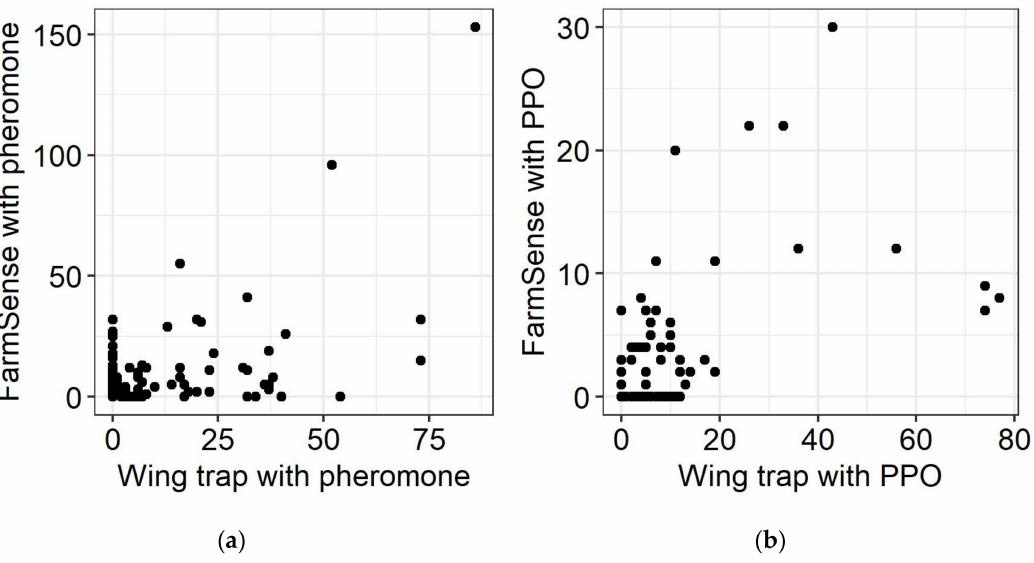
Figure 4. Association of counts from pseudoacoustic sensors and navel orangeworm captured in wing traps when both were baited with: ( a ) A pheromone monitoring lure ( ρ = 0.24, p = 0.02)); or ( b ) a phenyl propionate (PPO) dispenser ( ρ = 0.47, p <